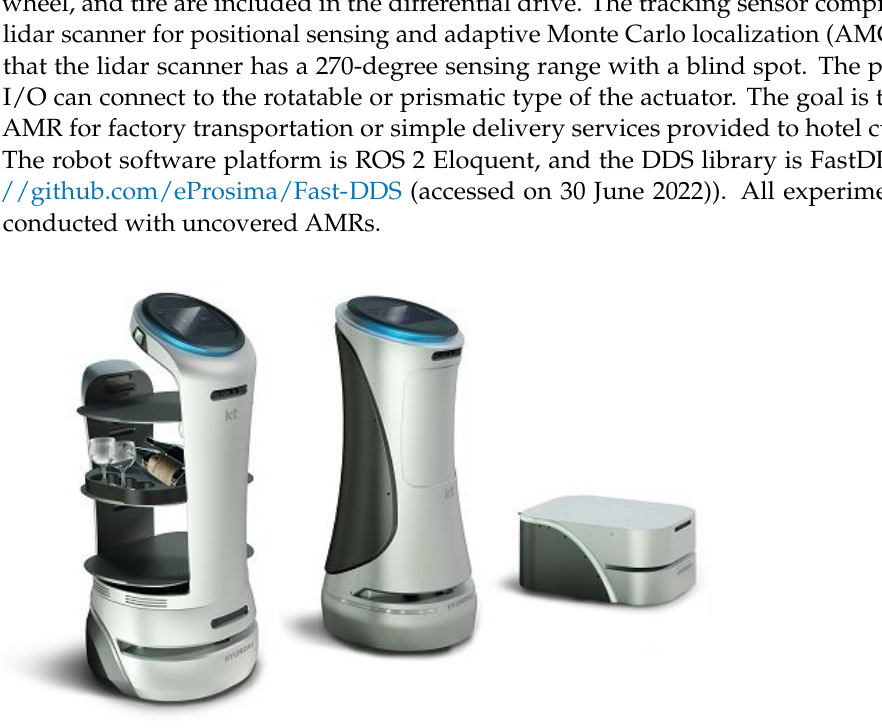
Figure 3. Hyundai Robotics AMRs lineup: two 50 kg payload and one 100 kg payload delivery